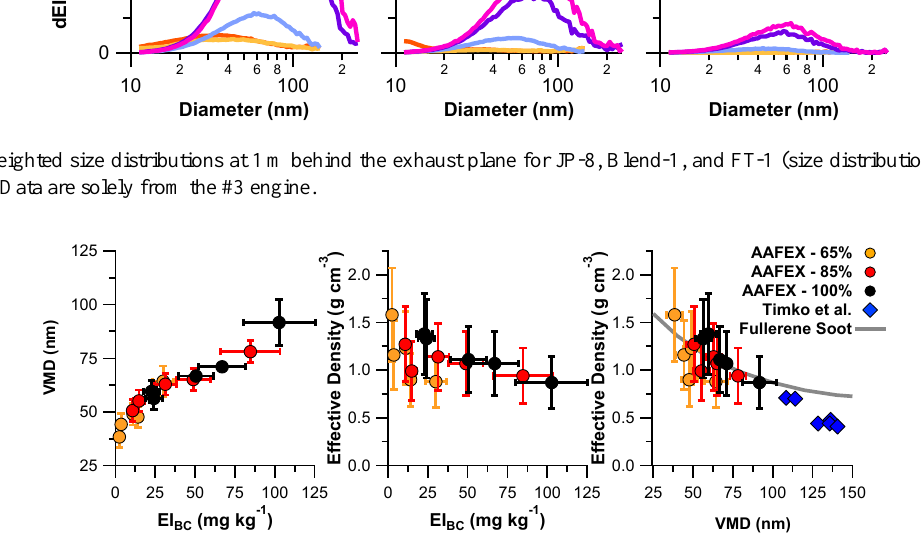
Fig. 5. Soot VMD increases (left) and density decreases (center) as EI BC increases for the AAFEX data set (1m behind the engine). Only 65–100% power settings were used because of low loadings below 65%. Fuel type is not differentiated but the pure FT fuels are those with the lowest black carbon loadings at each power. Plotting density versus VMD (right) allows for comparison with aircraft emission measurements by Timko et al. (2010) and laboratory studies of fullerene soot (Gysel et al., 2011). Data are solely from the #3